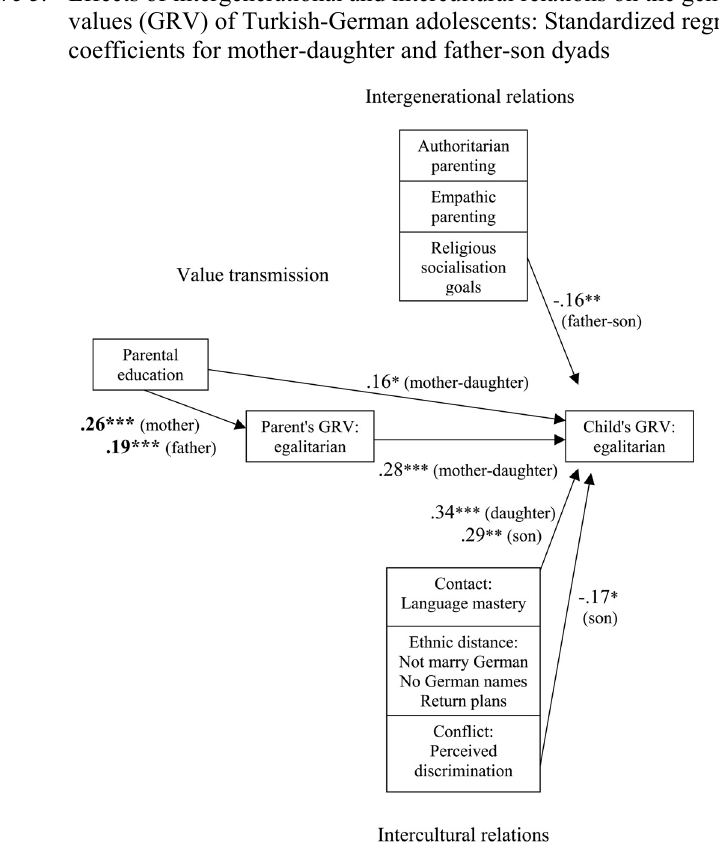
Figure 3. Effects of intergenerational and intercultural relations on the gender role values (GRV) of Turkish-German adolescents: Standardized